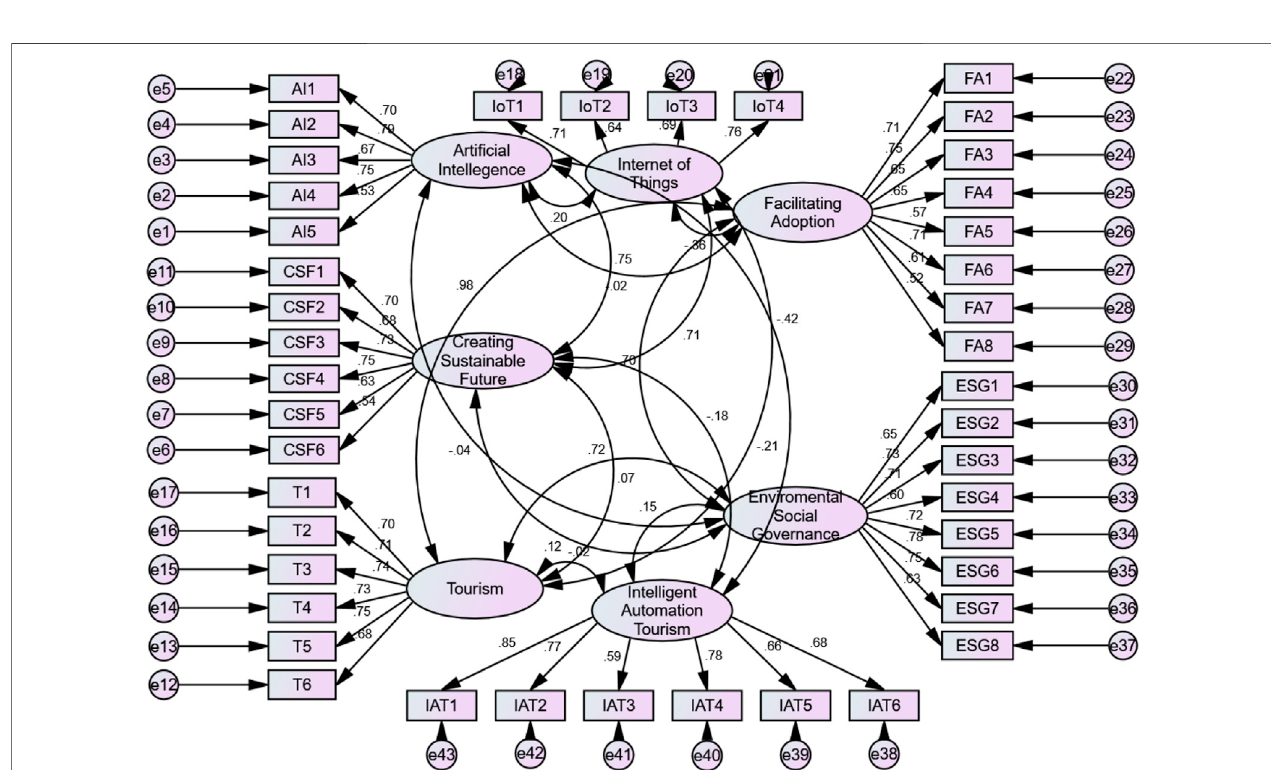
FIGURE 3 | Measurement of the arti fi cial intelligence, intelligence automation tourism, and internet of things ( N = 402).